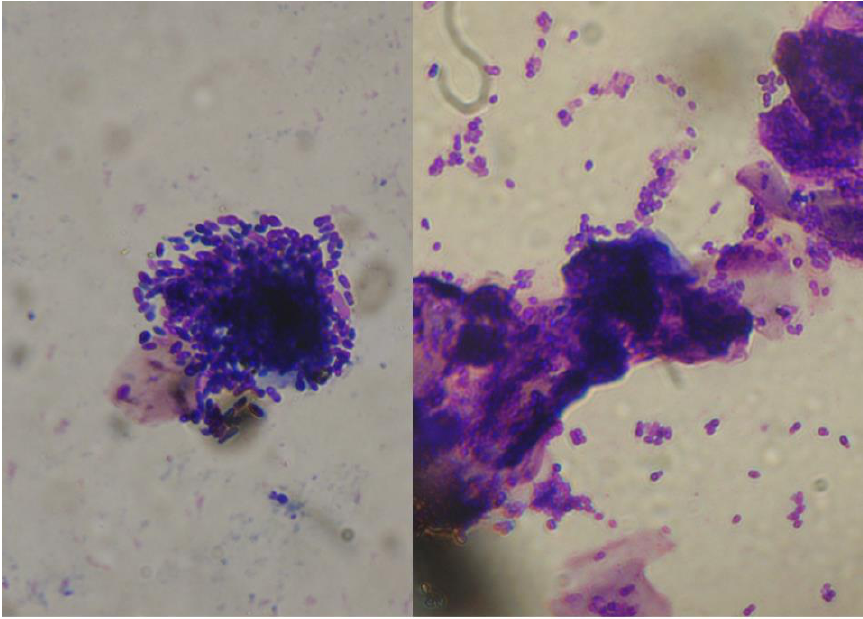
Figure 5. Cytology from ear discharge in two dogs with Malassezia otitis. Clumps including numerous yeast cells (400-fold magnification, Hemacolor ® rapid staining kit).